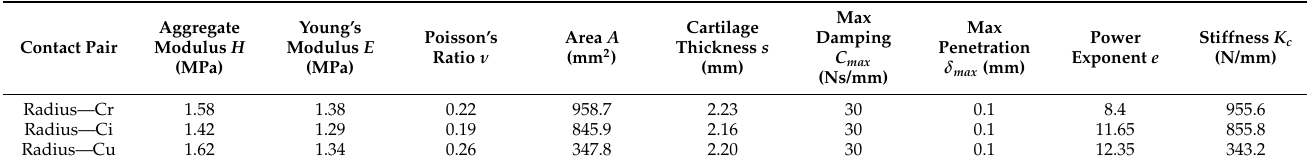
Table A3. Parameters involved in the articular contact.